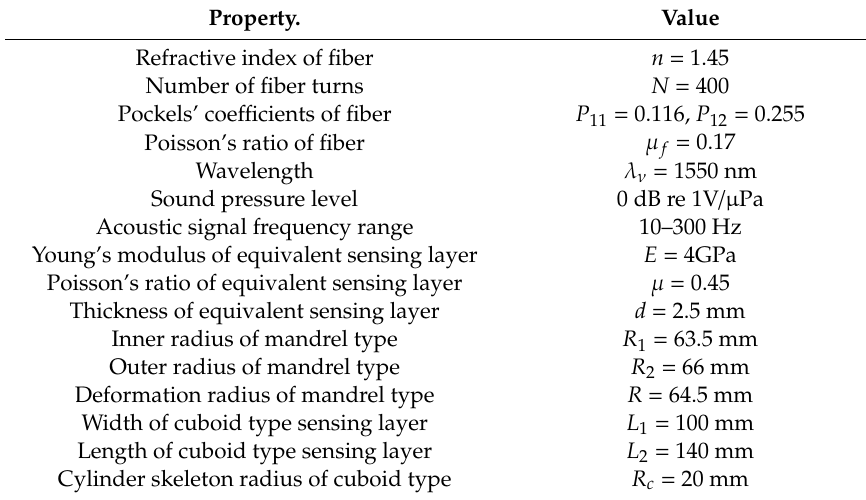
Table 1. Parameters used in theoretical phase-sensitivity